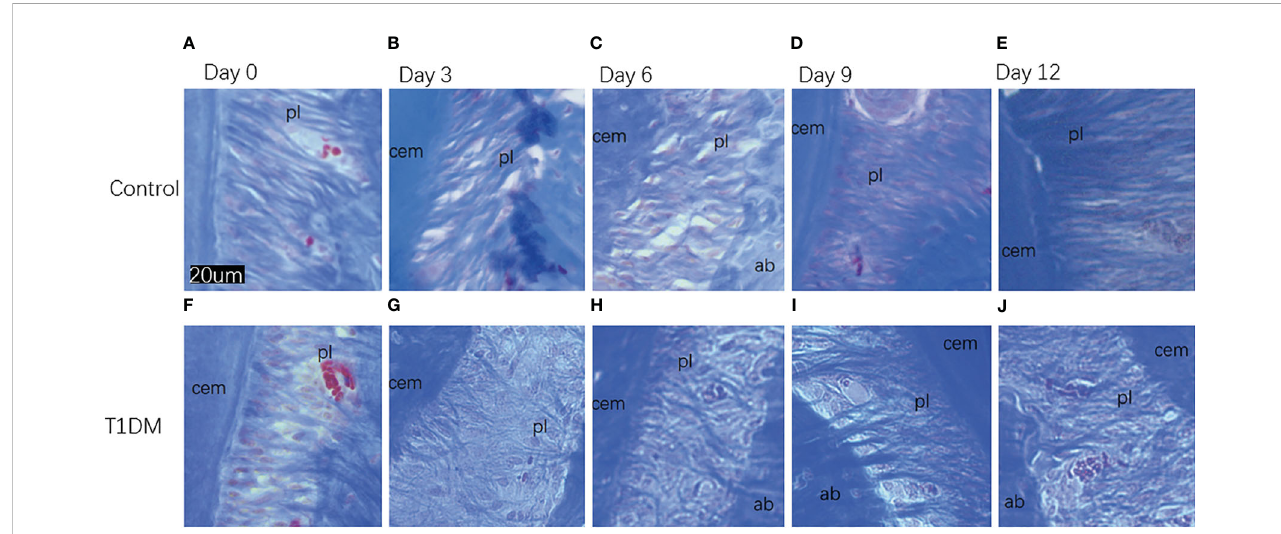
FIGURE 5 Histological appearance (Masson staining)of collagen fi bers in the periodontal ligament in both groups on days 0, 3, 6, 9, and 12 of the experiment. (A – E) are from control mice, (F – J) are from T1DM mice.In both groups, at 3 and 6 days after the extraction of the right maxillary molar, the collagen fi bers in the periodontal tissue of the mandibular molar began to arrange disorderly. At 9 and 12 days after the extraction, the collagen fi bers became compact. Compared with the control group, the collagen fi bers in the T1DM group were more sparse and disordered. cem, cementum; ab, alveolar bone; pl, periodontal ligament